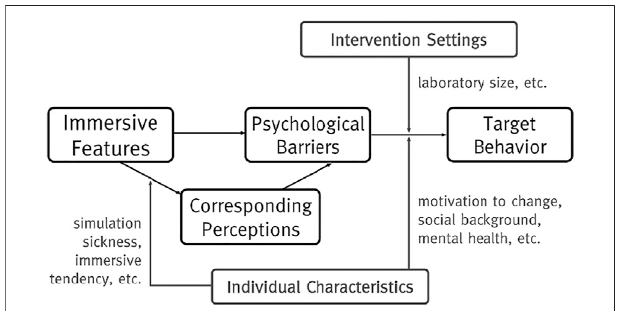
FIGURE 3 | Overview of the BehaveFIT impact paths showing the expected impact of immersive technologies, moderators, and situational factors on behavior